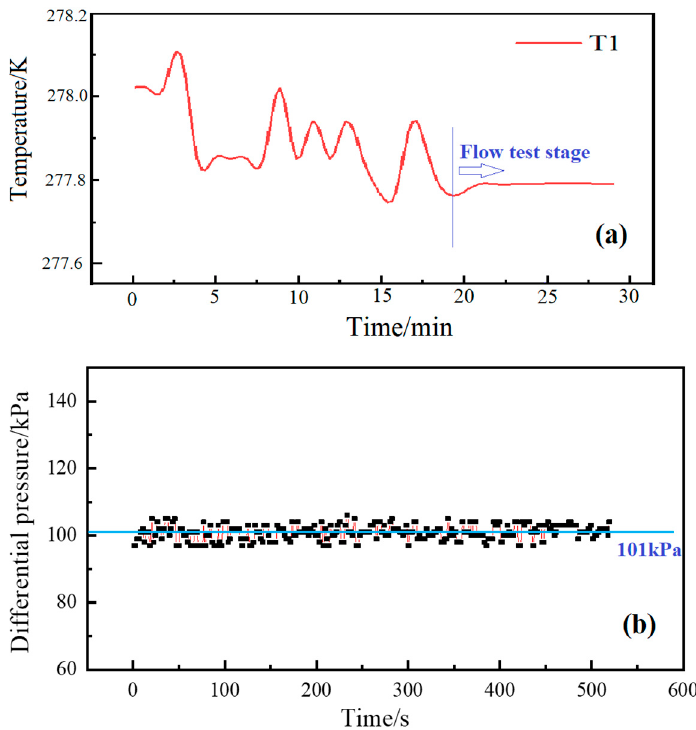
Figure 4. Temperature and differential pressure during permeability measurement: ( a ) temperature change during water injection, ( b ) differential pressure change during the stable water-injection stage.